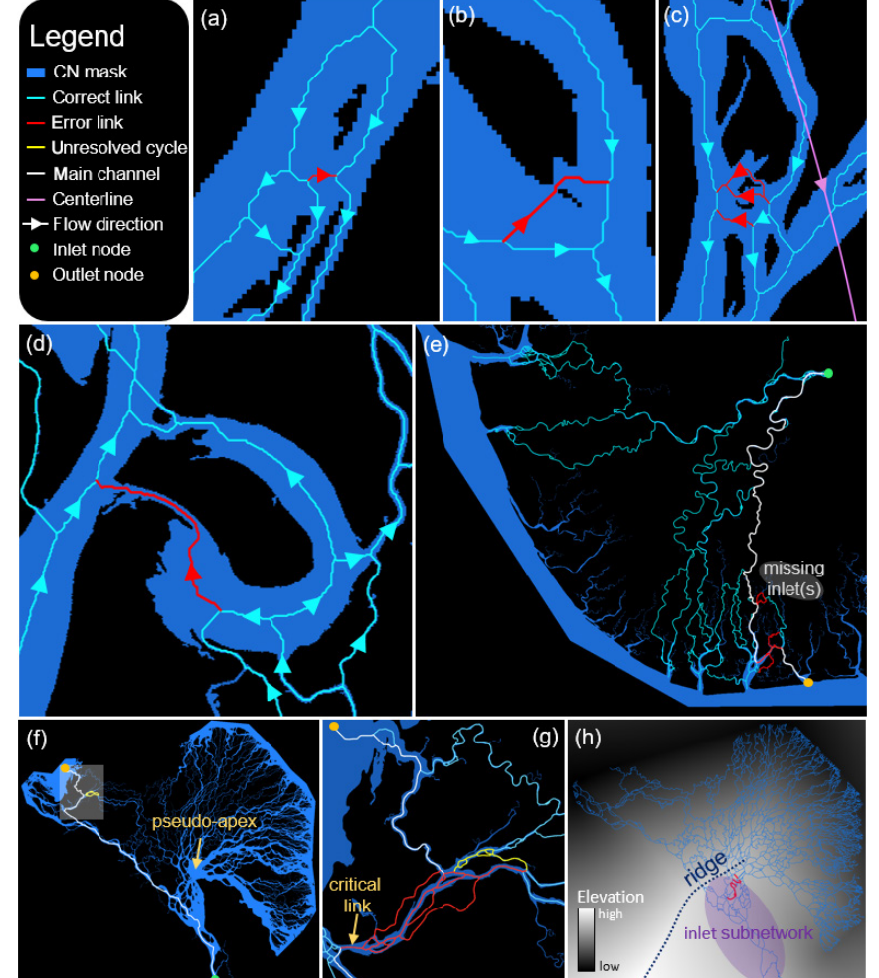
Figure 5. Errors of the recipes. (a–d) Ambiguous links that were erroneously set for the Mackenzie (a, d) , Indus (b) , and Brahmapu- tra (c) CNs. (e) The Niger CN features tidal channels whose inlets were not considered. A main channel is shown to an outlet node that should be fed by the missing inlets. (f) A problematic main channel (white) is shown for the Lena CN. A zoom view of the shaded area is shown in (g) . (h) Synthetic DEM for the Lena CN with a ridge of the synthetic DEM